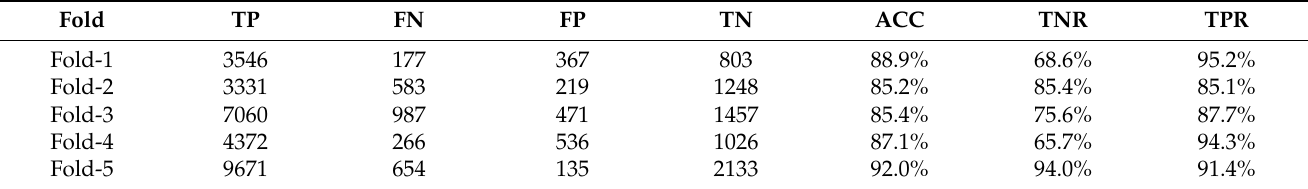
Table 4. Confusion matrix, ACC, TPR, and TNR of five-fold cross-validation for evaluating AIEFPC